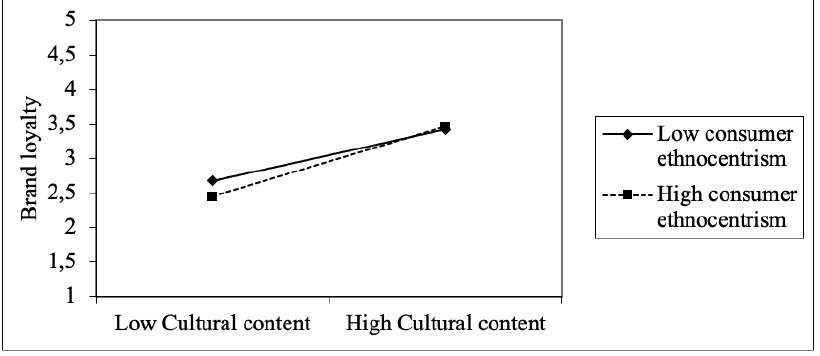
Figure 7: The moderating effect of consumer ethnocentrism on the relation between interactive content and brand identification